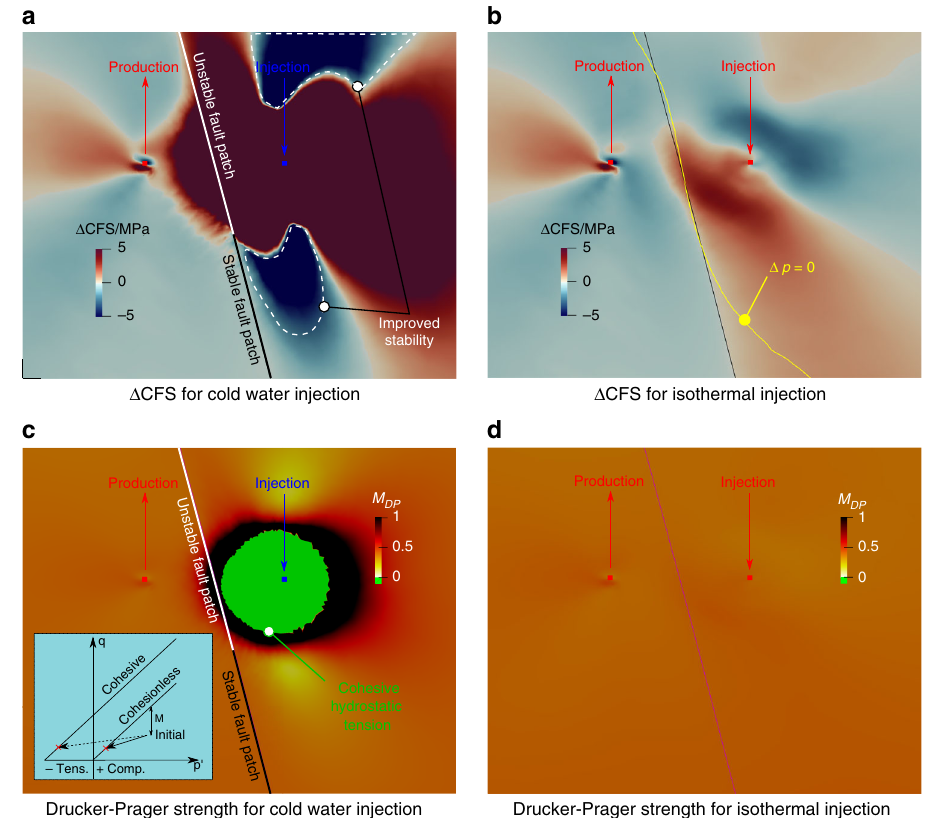
Fig. 5 Fault reactivation and reservoir stability. Coulomb Failure Stress changes ( Δ CFS ) after 25 years for the cold water ( a ) and isothermal injection ( b ) cases and Drucker-Prager mobilised failure ratio M DP after 25 years for the cold water ( c ) and isothermal injection ( d ) cases. Negative values of M σ 0 (cid:7) (cid:3) c 0 = tan ϕ : hydrostatic tension failure will be reached and tensile fractures will be likely to appear, as highlighted by the schematic DP imply m representation in the inset in